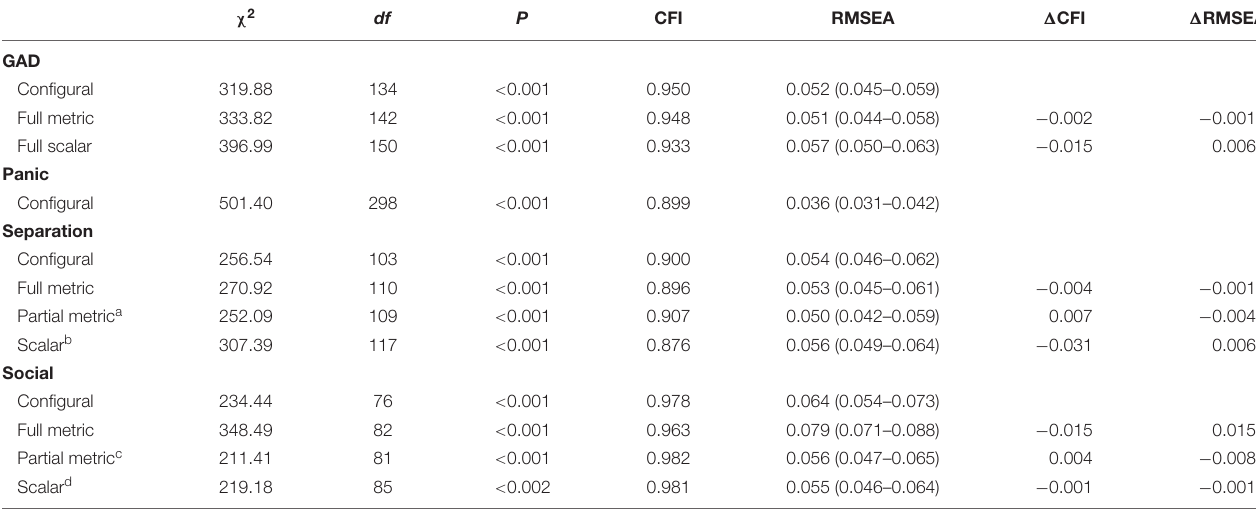
TABLE 5 | Tests of MI for maternal-reports across ages 9 and